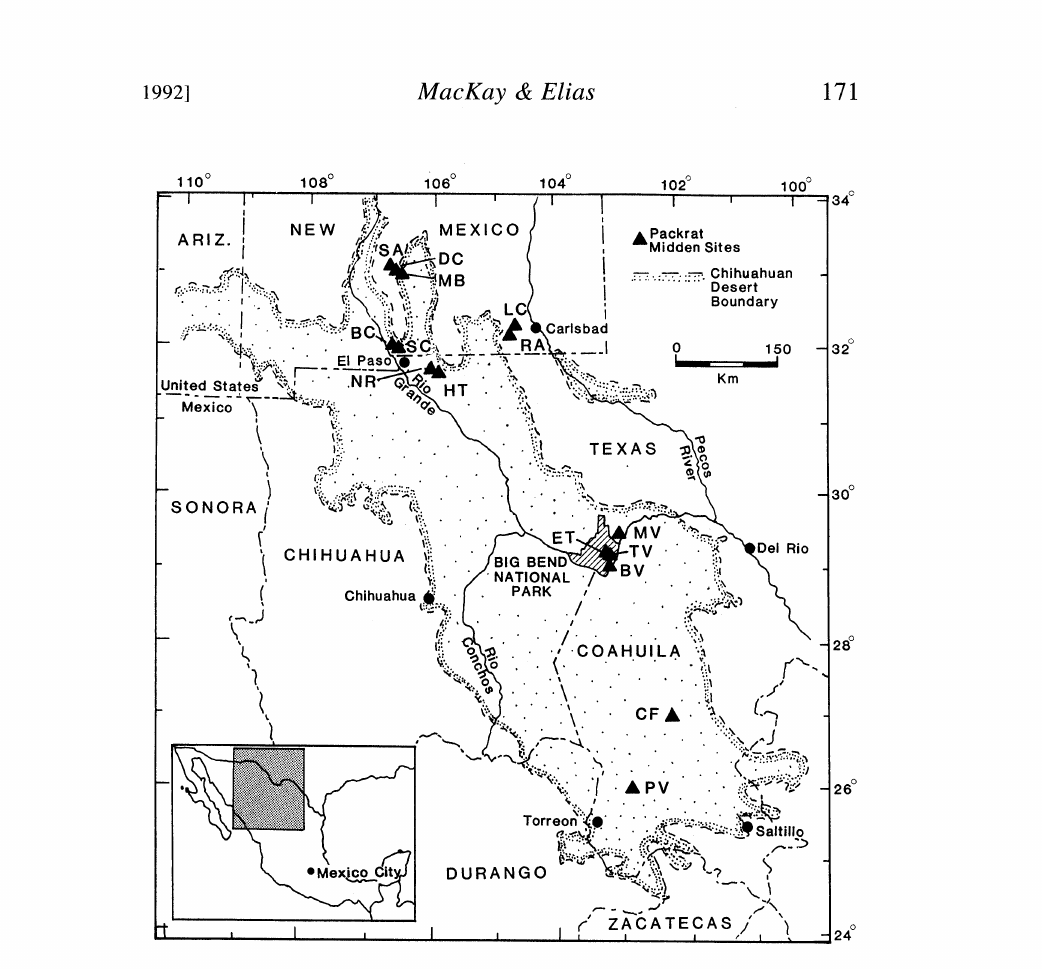
Figure 1. Map of the Chihuahuan Desert region, showing location of packrat midden sites from which ant fossils were identified. BC Bishop’s Cap, New Mex- ico; BV Baby Vulture Den, Big Bend National Park, Texas; CF Cation de la Fragua, Coahuila, Mexico; DC Dog Canyon, New Mexico; ET Ernst Tinaja, Big Bend National Park, Texas; HT Hueco Tanks State Park, Texas; LC Last Chance Canyon, New Mexico; MB Marble Canyon, New Mexico; MV Maravillas Canyon Cave, Black Gap Wildlife Management Area, Texas; NR Navar Ranch, Texas; PV Puerto de Ventanillas, Coahuila, Mexico; RA Rocky Arroyo, New Mexico; SA San Andr6s Mountains, New Mexico; SC Shelter Cave, New Mex- ico; TV Tunnel View site, Big Bend National Park,